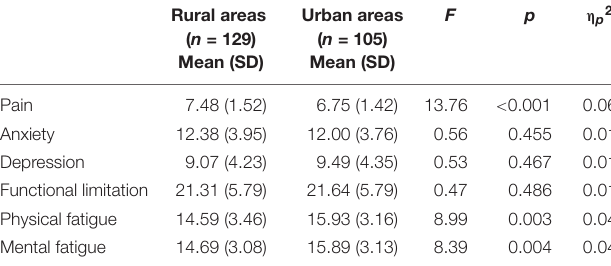
TABLE 2 | Differences in symptoms between patients from rural and urban